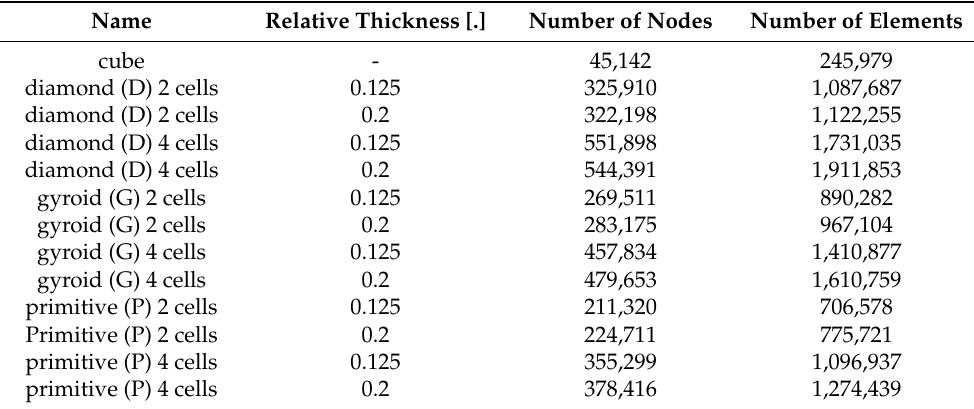
Table 2. Details of finite element meshes used for obtaining presented